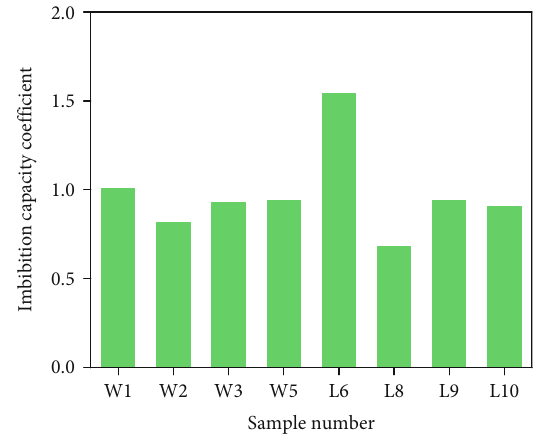
Figure 6: Imbibition capacity coe ffi cient of di ff erent deep shale